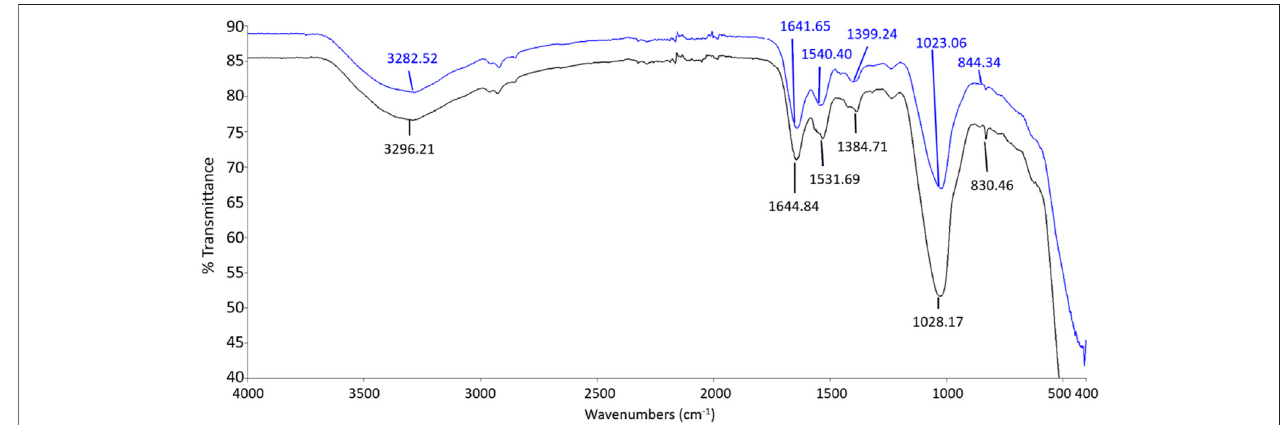
FIGURE 6 | FTIR spectrum of S. marcescens as negative control (black line) and S. marcescens treated with 160 μ g/ml of ZnO NPs for 24 h (blue